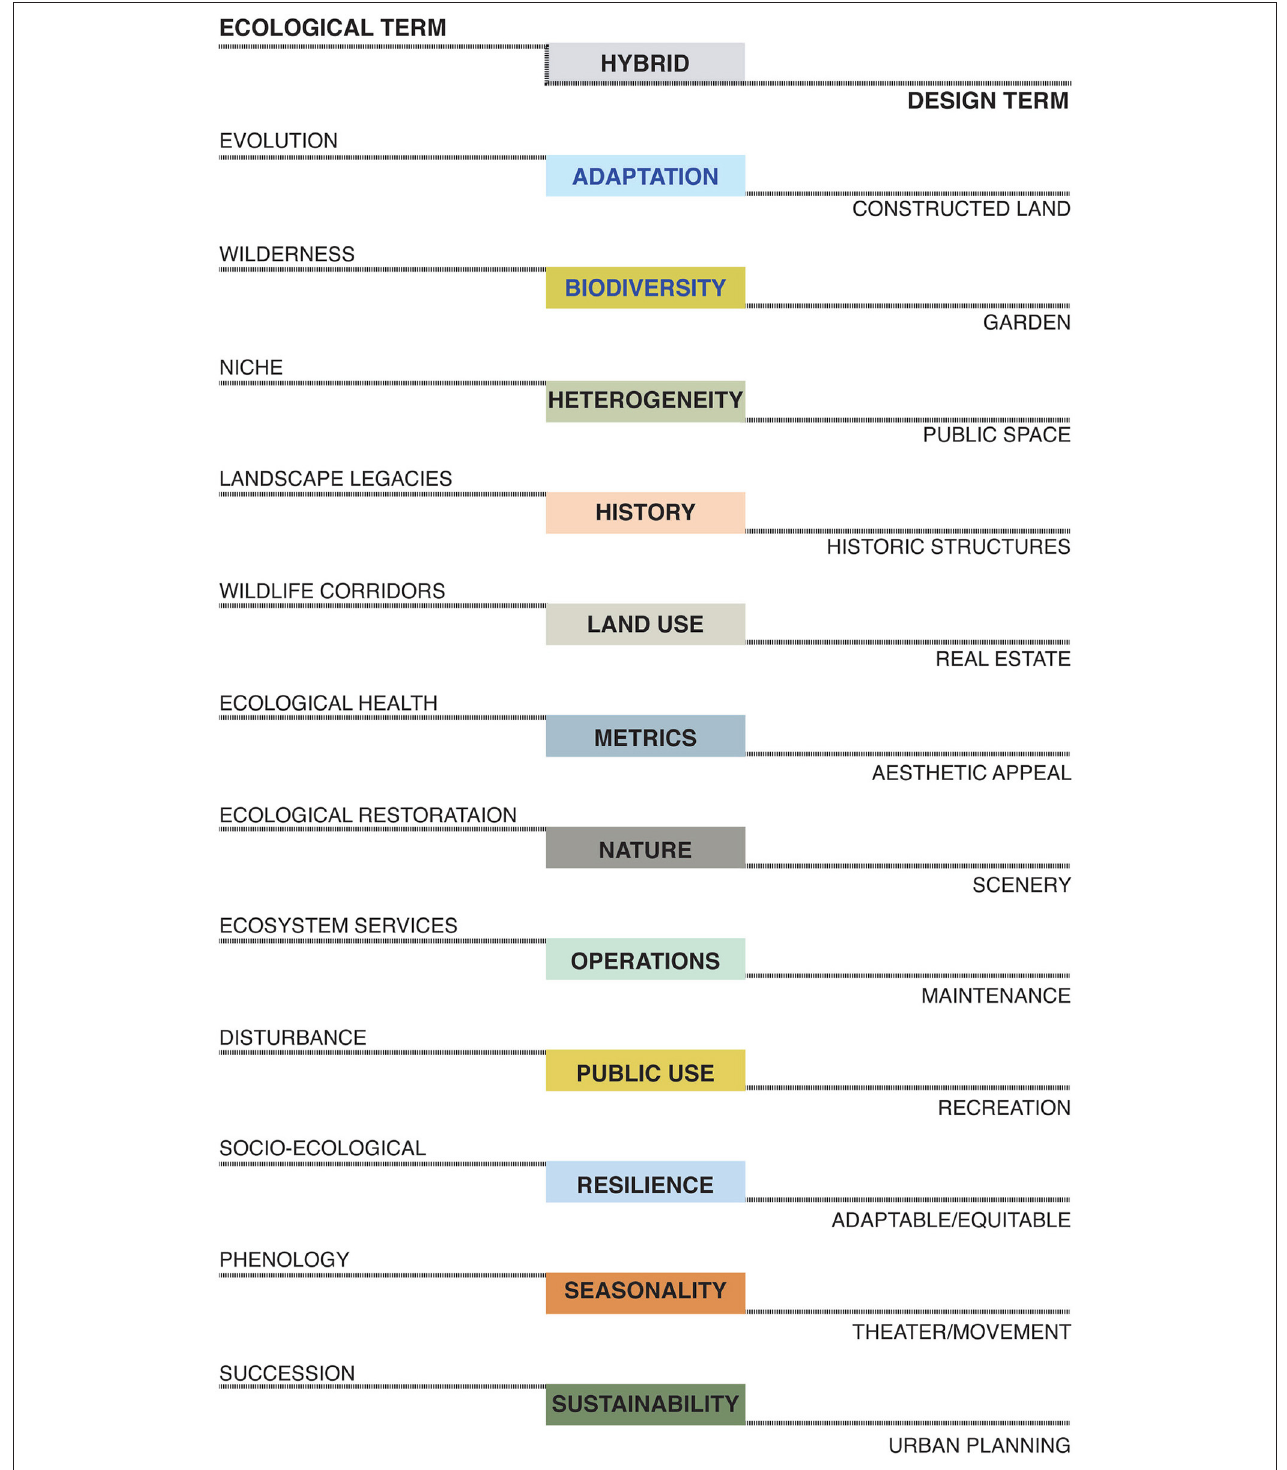
FIGURE 3 | Ecologists (E) and Designers (D) have different interpretations of and use different words for similarly-named conceptual domains. The interpretations or words on the left and right are intentionally offset to suggest differences in understanding between the ecologists and designers (paralleled by the form vs. function “see-saws” in Figure 1 and “sliders” in Figure 10 ). These differences make it difficult for ecologists and designers to communicate and collaborate effectively. The interpretations and words are connected through their concepts (center) to suggest opportunities for alignment. Identifying and building on areas of shared interest and teaching across disciplines can strengthen collaborations between ecologists and designers. Image by Alexander Felson/UED Lab and used with permission.